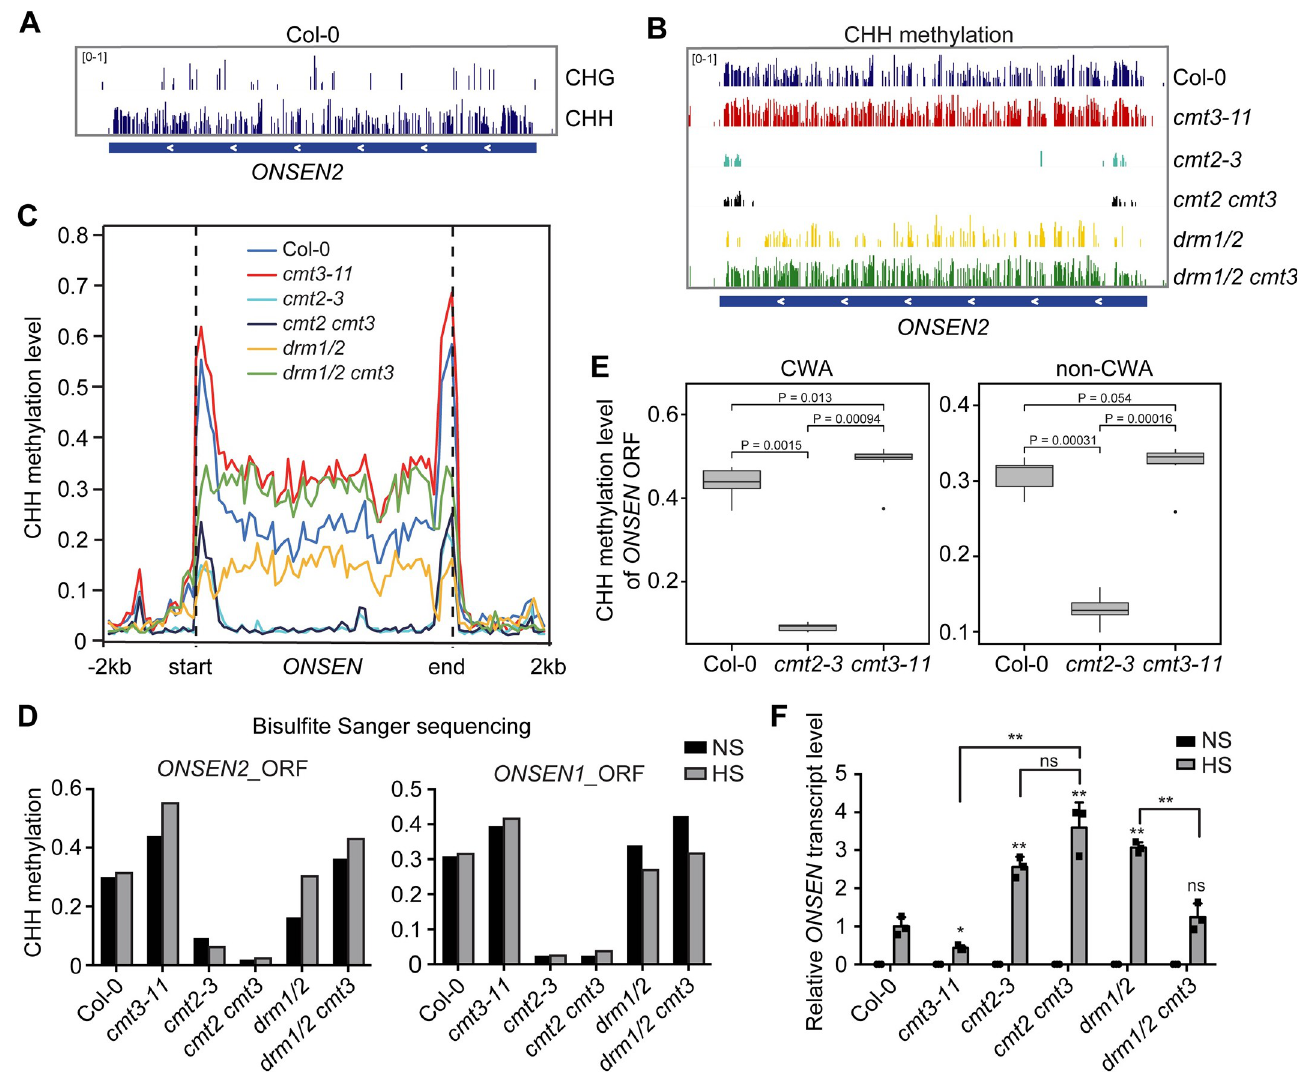
Fig 3. CHH hypermethylation at ONSEN in cmt3 is mediated by CMT2. (A) Genome browser view of CHG and CHH methylation within ONSEN2 (AT3TE92525/AT3G61330), in Col-0. (B) Genome browser view of CHH methylation within ONSEN2 in Col-0, cmt3-11 , cmt2-3 , cmt2 cmt3 , drm1/2 , and drm1/2 cmt3 . (C) Metaplots showing average CHH methylation of 8 ONSEN copies in the corresponding mutants. -2kb indicates the upstream 2000 bp of the start site, and 2kb indicates the downstream of 2000 bp of the end site. (D) Bisulfite Sanger-sequencing for CHH methylation level of the ORFs of ONSEN2 and ONSEN1 , two ONSEN copies highly induced by heat stress, in the corresponding mutants under non-stress (NS) and heat stress (HS). (E) Boxplots showing CWA (CAA and CTA) and non-CWA CHH methylation level in Col-0, cmt2-3 , and cmt3-11 of the open reading frame (ORF) of all eight copies of ONSEN . P-values are from Wilcoxon test. (F) RT-qPCR of ONSEN transcripts in the corresponding mutants under NS and HS. All bars represent mean + SD from two biological replicates. The ONSEN transcripts were normalized to 18S rRNA . Student’s t -test, � P < 0.05; �� P < 0.01. ns indicates not